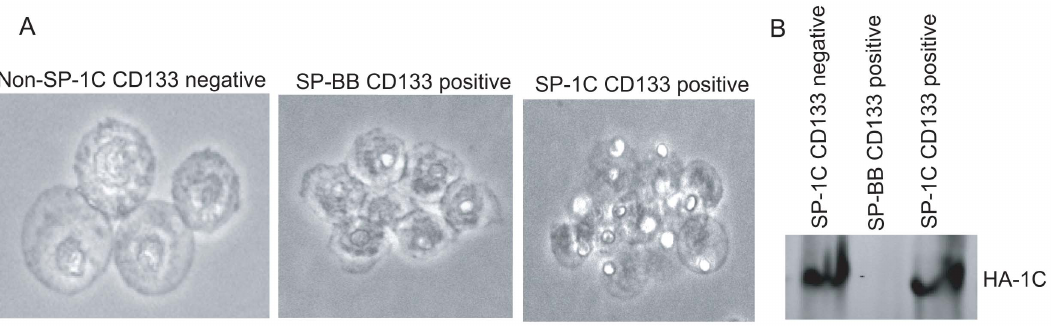
Figure 3. CD133 + cells expressing RASSF1C form tumor spheres more robustly than control cells. (A) Non-SP-1C CD133 - , SP-BB CD133 + , and SP-1C CD133 + cells isolated from the A549 lung cancer cell line were grown in serum free medium supplemented with 10 ng/ml EGF and 20 ng/ ml FGF to promote tumor sphere formation for three wk. (B) A549 cells repopulated from tumor spheres were checked for HA-RASSF1C expression using HA-antibody. As expected, SP-1C CD133- and CD133 + expressed HA-RASSF1C, while SP-BB cells did not. Data is representative of at least 3 independent experiments.